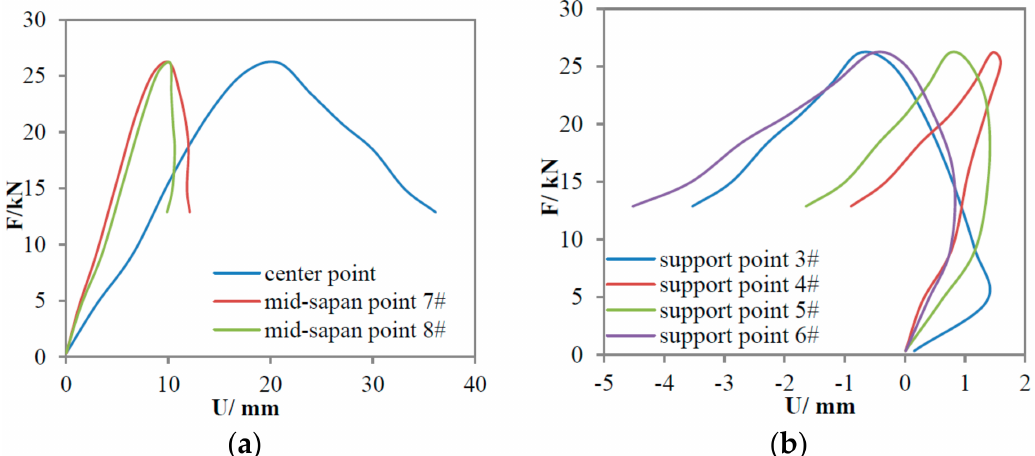
Figure 11. Load deflection F-U curve of specimen PD-40-1. ( a ) Deflection of the support point; ( b ) Deflection of the center and mid-span